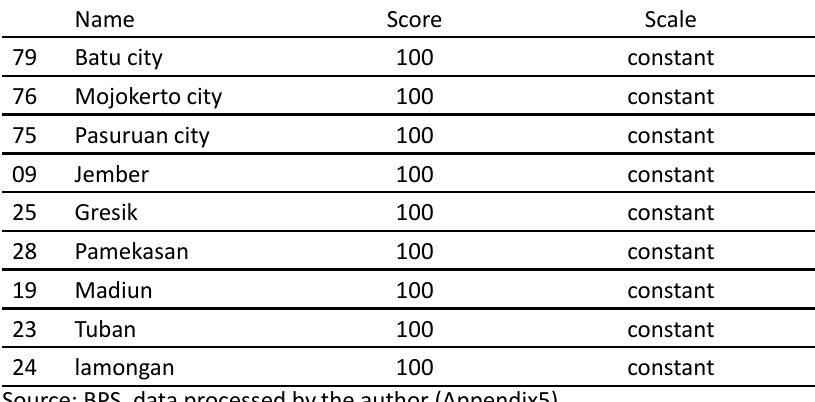
Table 5: Production Efficiency Based on Spatial